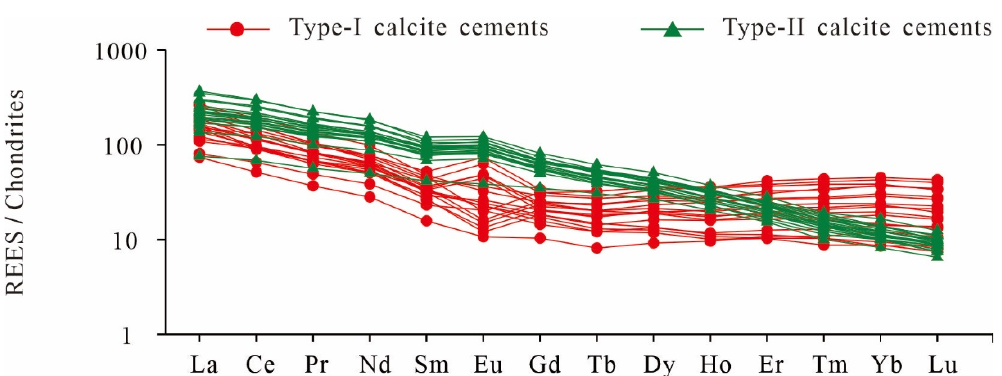
Figure 9. Characteristics of rare earth elements of calcite cements. Type-I calcite cements are from samples of W484 (2009.4 m), X522 (2041.06 m), G122 (2065.6 m), X410 (2025.1 m); type-II calcite cements are from samples of G6 (2001.75 m).